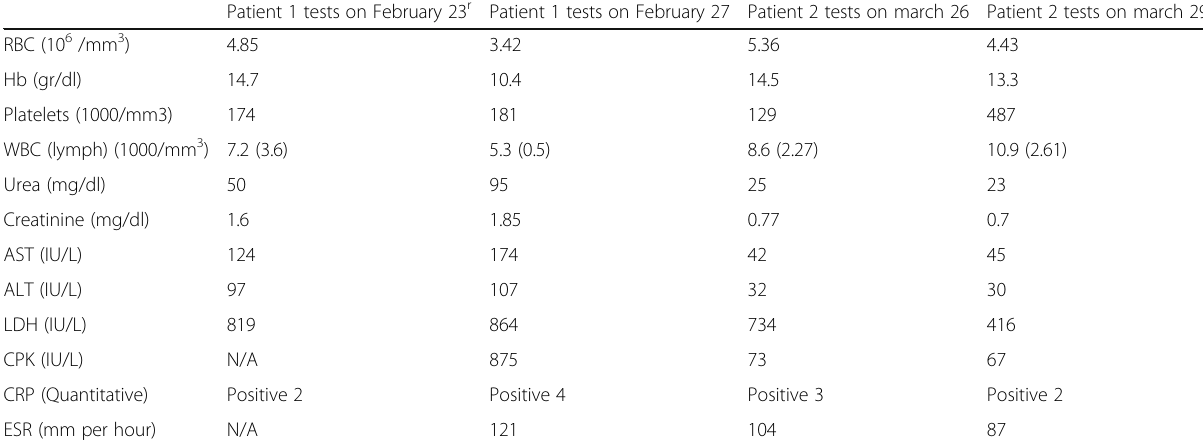
Table 1 Lab data of the patients being studied